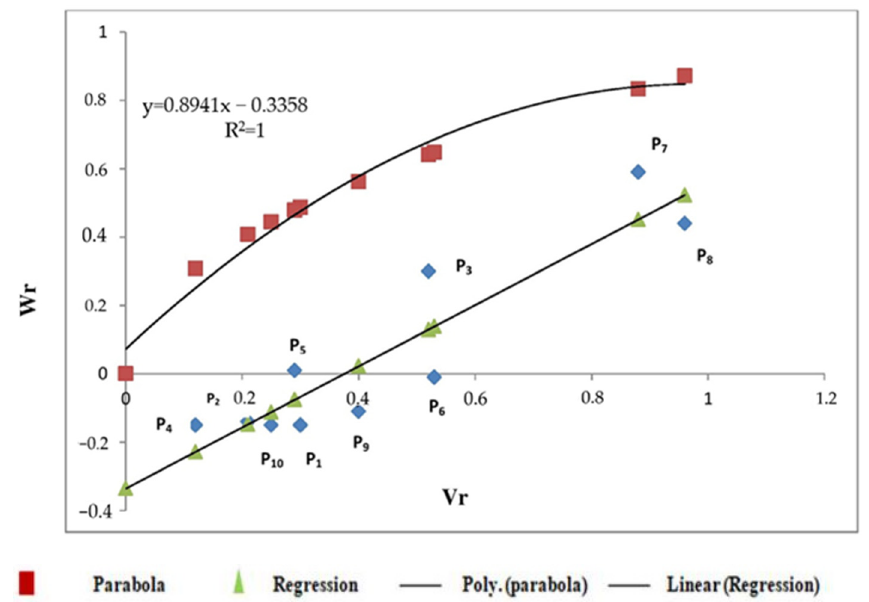
Figure 2. Wr–Vr graph for protein content in E 3 . P1 = GW 451; P2 = GW 496; P3 = LOK 1; P4 = GW 322; P5 = GW 366; P6 = HI 1544; P7 = GW 173; P8 = GW 11; P9 = HD 2864; P10 = UAS 385.